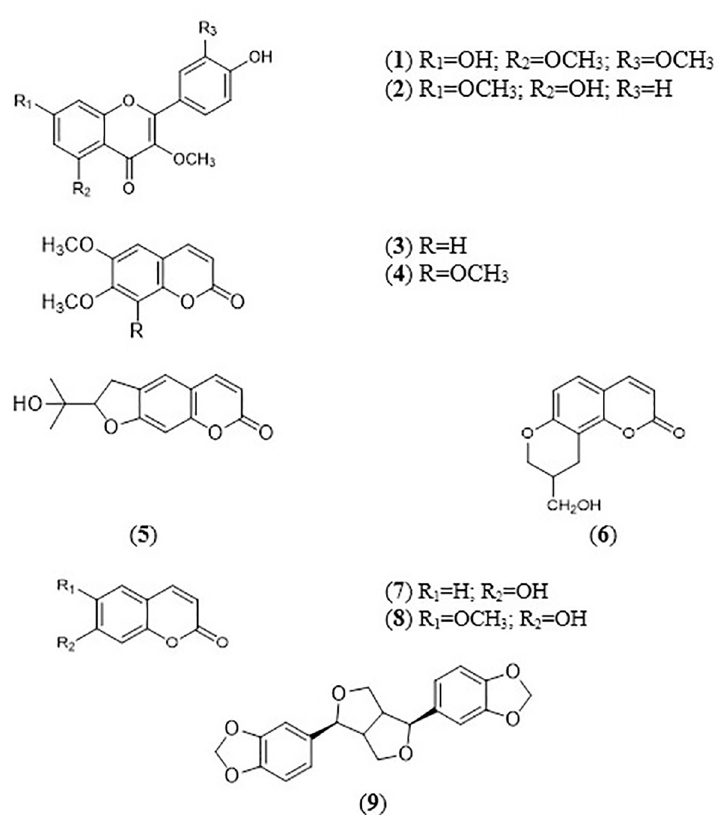
Fig 1. Structures of compounds 1–9 isolated from M . glabra ethyl acetate and methanol extracts.